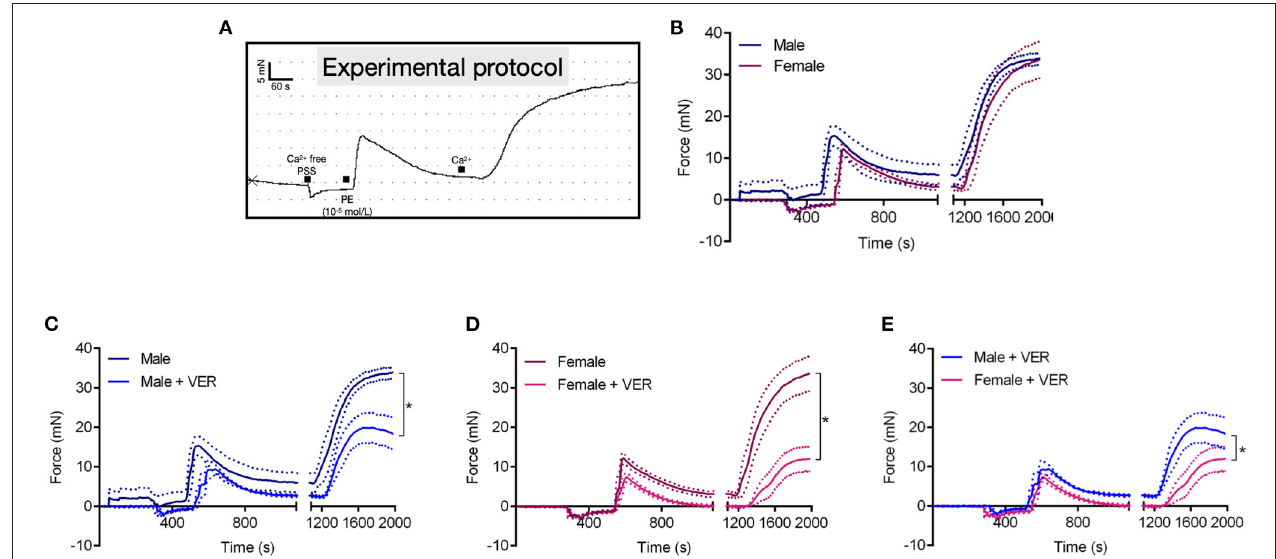
FIGURE 3 | Blockade of HSP70 greatly affects Ca 2+ influx-mediated vascular contraction in female compared with male rats. Schematic of the protocol used in this set of experiments (A) . Male and female aortic rings were stimulated with phenylephrine (10 − 5 mol/L) in Ca 2+ free physiological salt solution for 10 min. Subsequently, the extracellular concentration of Ca 2+ was restored and the force developed was analyzed for 15 min (B) . (C–E) Show the data for male, female, and male vs. female, respectively in the presence of vehicle or VER155008 (10 − 5 mol/L). Data points were sampled every second for 1,980 s and are expressed as mean ± SEM, where the continuous line represents the mean and the traced lines depict the SEM. n = 4, * p ≤ 0.05 using one-way ANOVA followed by the Bonferroni